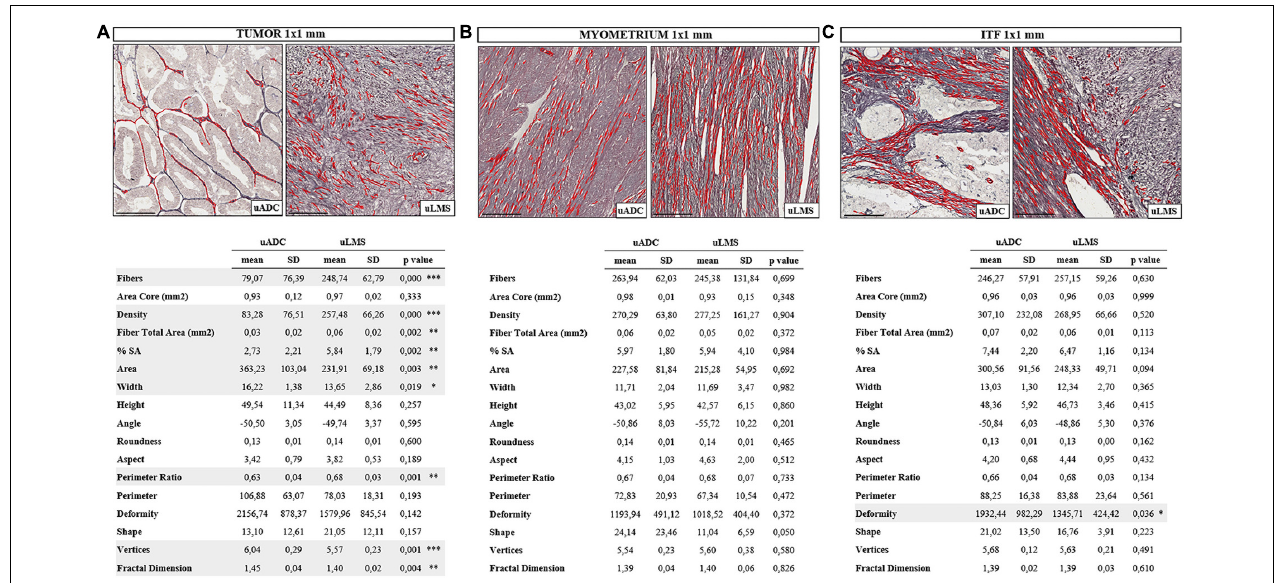
FIGURE 2 | In-depth invasive tumor front (ITF) histomorphometric characterization of reticular fibers in uterine adenocarcinomas (uADC) and leiomyosarcomas (uLMS) reveals a high degree of architectural similarity. Representative image of fiber segmentation in 1 × 1-mm tumor ROIs in uADC and uLMS. Comparison of morphometric parameters obtained after reticular fiber segmentation between uADC and uLMS in panels (A) Intratumor 1 × 1-mm ROIs. (B) 1 × 1-mm myometrium ROIs, and (C) 1 × 1-mm invasive tumor front (ITF) ROIs in uADC and uLMS. Reticular fibers are highlighted in red. Fisher–Snedecor test and Student T -test were applied for statistical comparison. Mean, standard deviation (SD), p -Values, and significance ( ∗ < 0.05, ∗∗ < 0.01, ∗∗∗ < 0.001) are shown. Total fibers, area of the core, and sum of the total area of fibers were measured to calculate the density (number of fibers/mm 2 ) and percentage of stained area (% SA). Area in µ m 2 . Length and width in µ m. Scale bars represent 250 µ m.